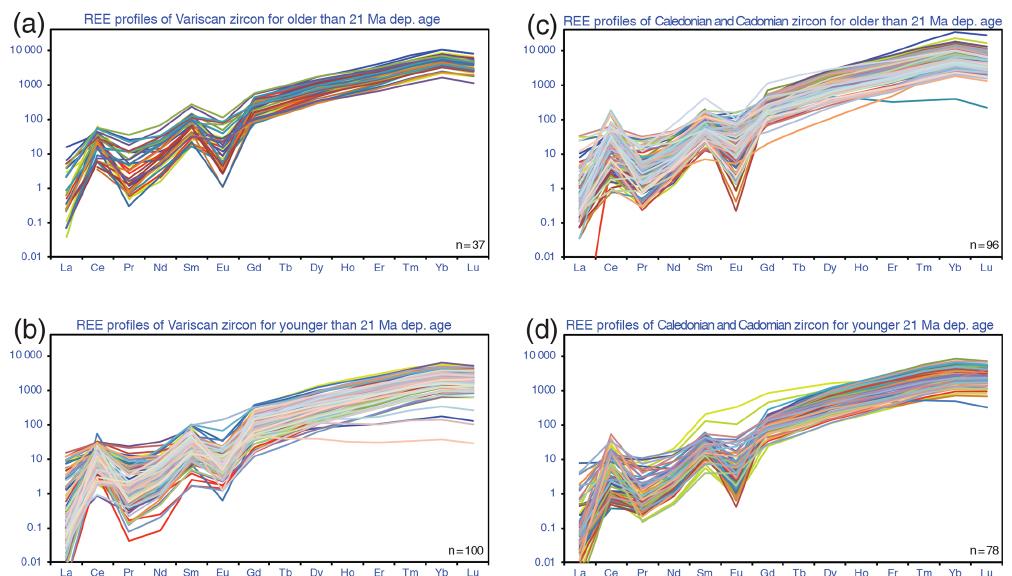
Figure 7. Detrital zircon rare-earth element (REE) spider diagram for samples collected from the Lucerne Section. (a) Variscan U–Pb ages and REE data for samples older than a 21Ma depositional age and (b) younger than a 21Ma depositional age. (c) Caledonian and Cadomian U–Pb ages and REE data for samples older than a 21Ma depositional age and (d) younger than a 21Ma depositional age. For ( a ) and ( c ) the geochemical data are drawn from samples SFB21 (22.5Ma) and SFB45 (27Ma). For (b) and (d) the geochemical data are drawn from samples SFB33 (20.5Ma), SFB49 (19Ma), SFB14 (17.5Ma), and SFB38 (13.5Ma). n is the number of REE profiles available. The data suggest that detrital zircons from all three recent orogenic cycles record primarily grains that are magmatic in origin (Belousova et al., 2002; Hoskin and Ireland, 2000). However, there are an increased number ( n = 4) of flat HREE profiles (indicative of a metamorphic origin; Rubatto, 2002) for Variscan grains from strata younger than 21Ma. Data can be found in Table